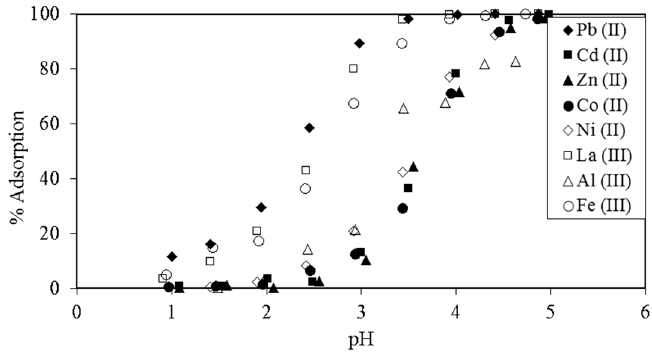
Figure 1. % adsorption of different metal ions by crosslinked lignocatechol gel at different pH values at equilibrium. Initial metal ion concentration = 0.2 mM, dry weight of lignocatechol gel = 20 mg, test solution volume = 15 mL [6]. (With permission for reuse from Elsevier B.V.).